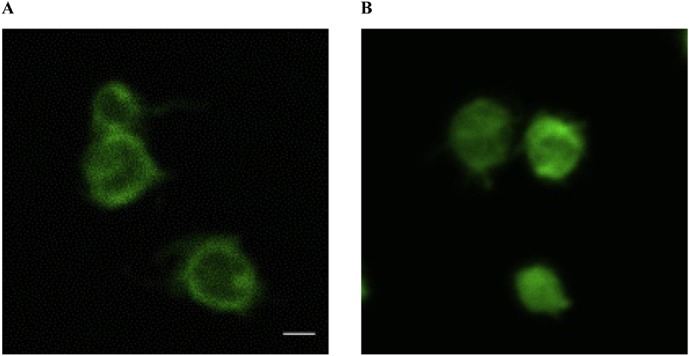
MPO induces actin cytoskeleton reorganization.Platelets were incubated at 37°C for 10 minutes without (A) or with (B) MPO (100 nM) and then fixed with 4% paraformaldehyde for 10 minutes at room temperature before further processing as described in Materials and Methods. Actin was visualized with BIODIPY FL phallacidin using a confocal microscope. Scale bar: 1 µm. The micrographs shown are representative of three separate experiments.